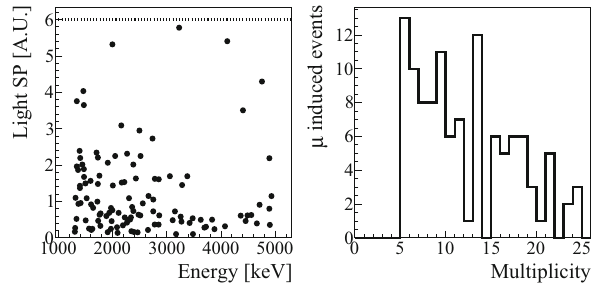
signal. Looking at this distribution we set the cut SP < 6, the